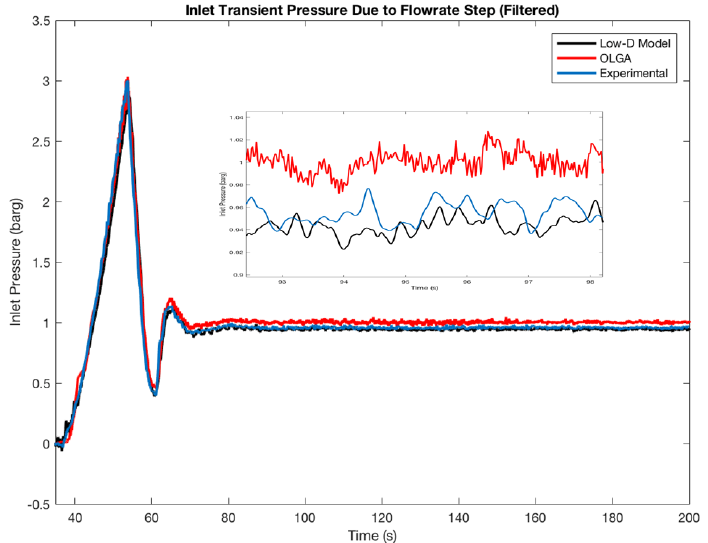
Figure 15. Experimental vs. simulations (Inlet Pressure, liquid with entrained air/case 2).